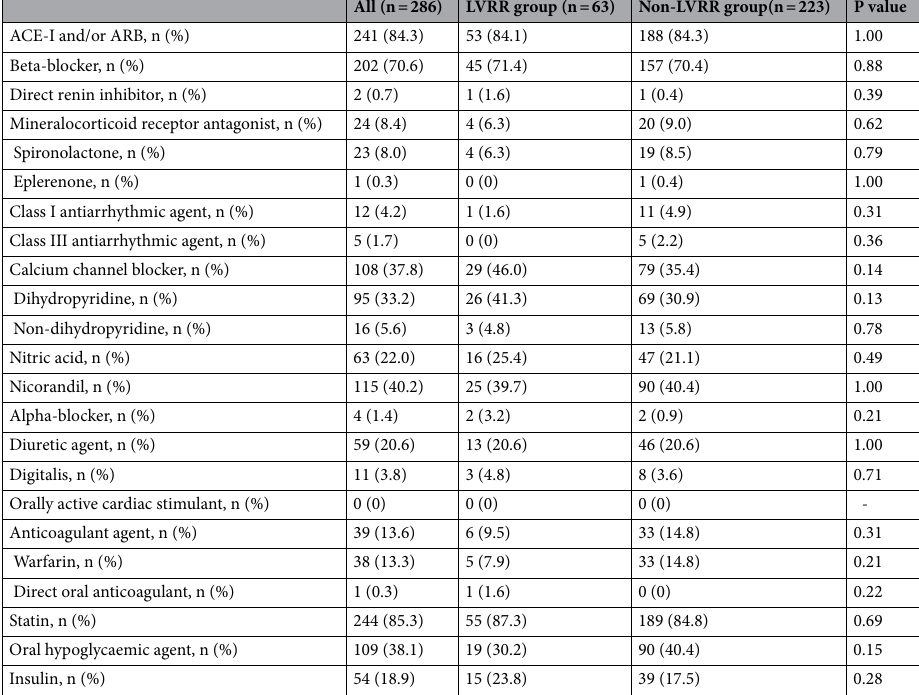
Table 4. Medications at discharge after PCI. Data are expressed as numbers (%). ACE-I angiotensin converting enzyme inhibitor; ARB angiotensin II receptor